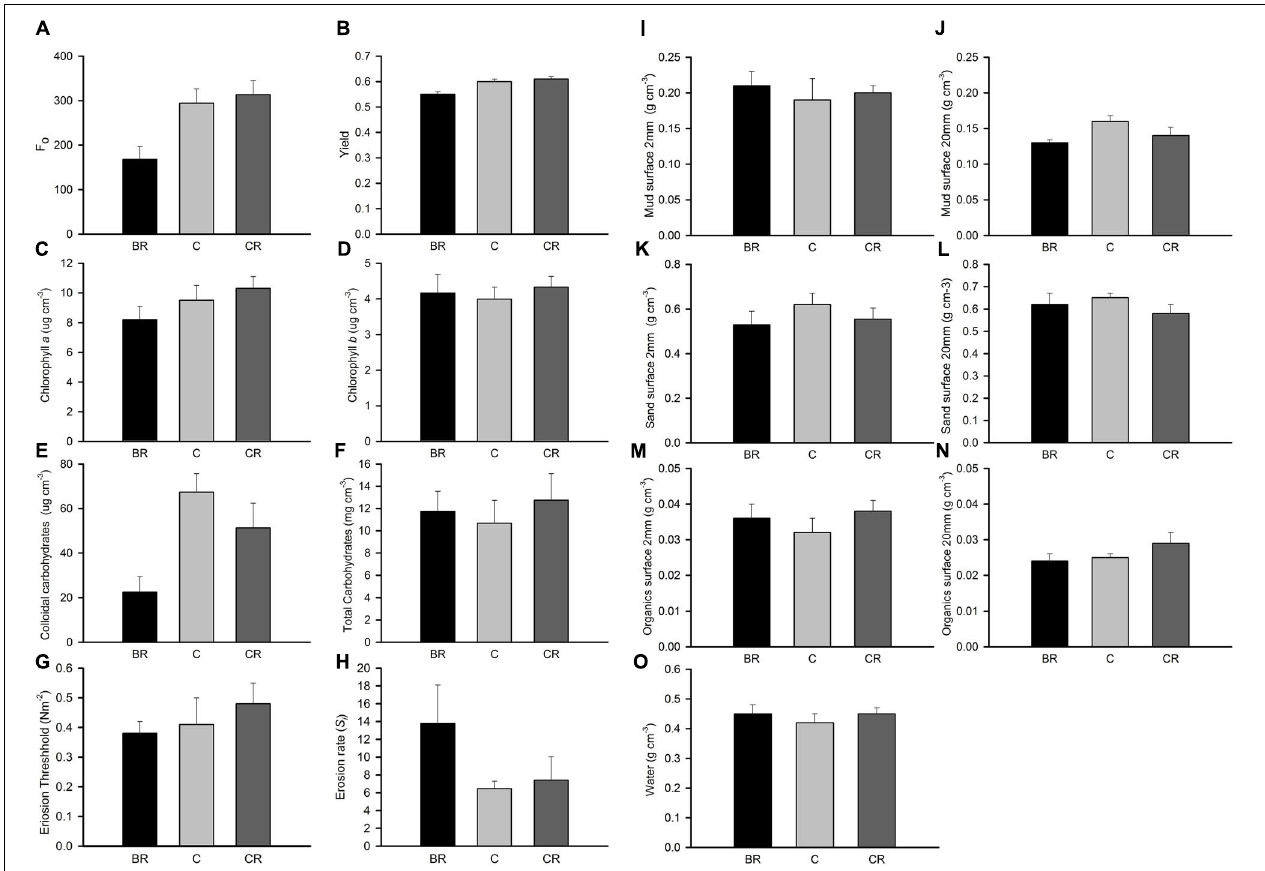
FIGURE 6 | Gore Creek properties of sediment after 2 weeks, mean (SE) for panel (A) F o , (B) yield, (C) chlorophyll a , (D) chlorophyll b , (E) colloidal carbohydrates, (F) total carbohydrates, (G) erosion threshold, (H) erosion rate, (I) mud from 2 mm deep core, (J) mud from 20 mm deep core, (K) sand from 2 mm deep core, (L) sand from 20 mm deep core, (M) organics from 2 mm deep core, (N) organics from 20 mm deep core, and (O) water from 2 mm deep core. F o and F v / F m measured with a PAM (unitless); erodibility measured with a CSM, erosion threshold (N m − 2 ), erosion rate (dimensionless); all other measures are mass density (wt per cm − 3 ).